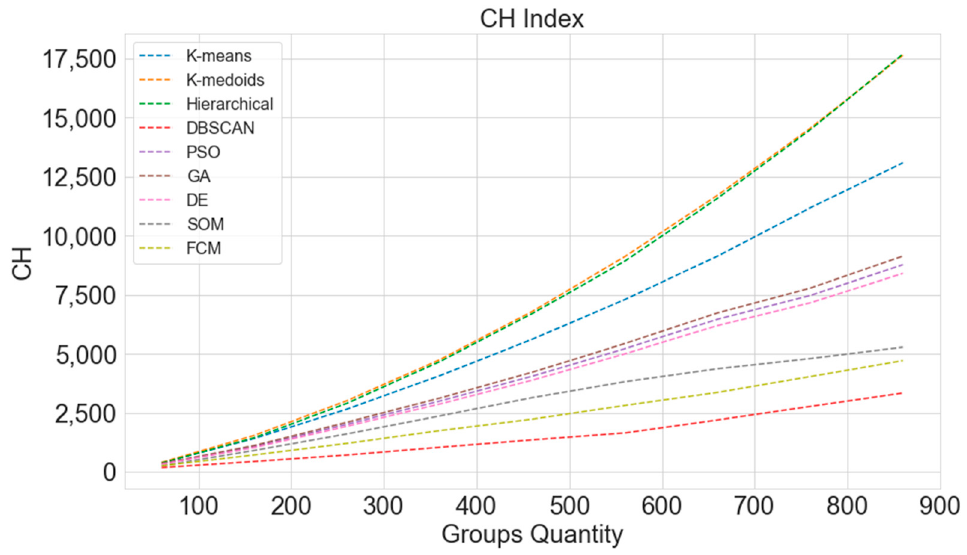
Figure 9. CH index evaluation over different group amounts considering nine clustering methods.